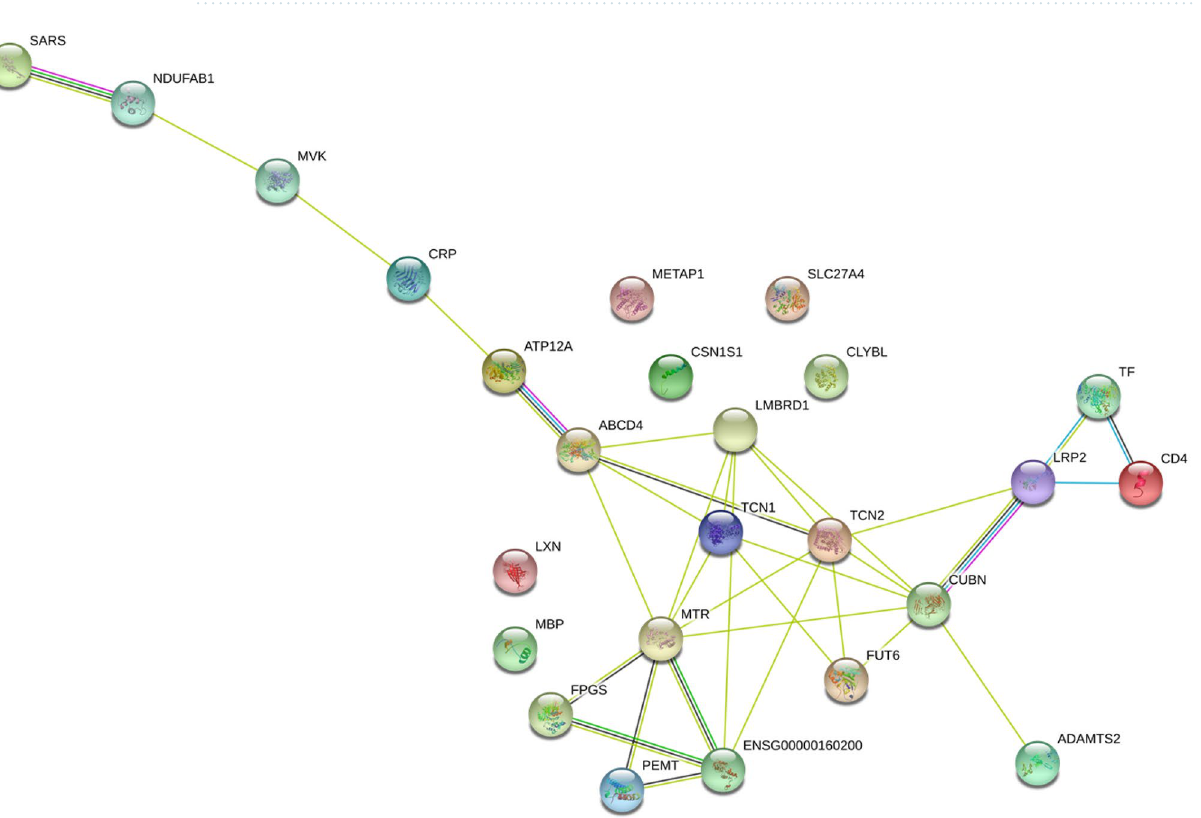
Figure 3. 26 genes in a protein–protein association network for vitamin B12, using